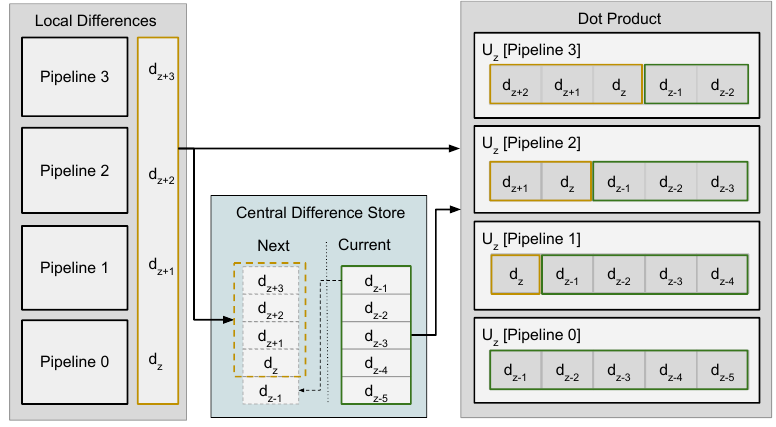
Figure 6. Routing of central differences between pipelines for N p = 4 and P =